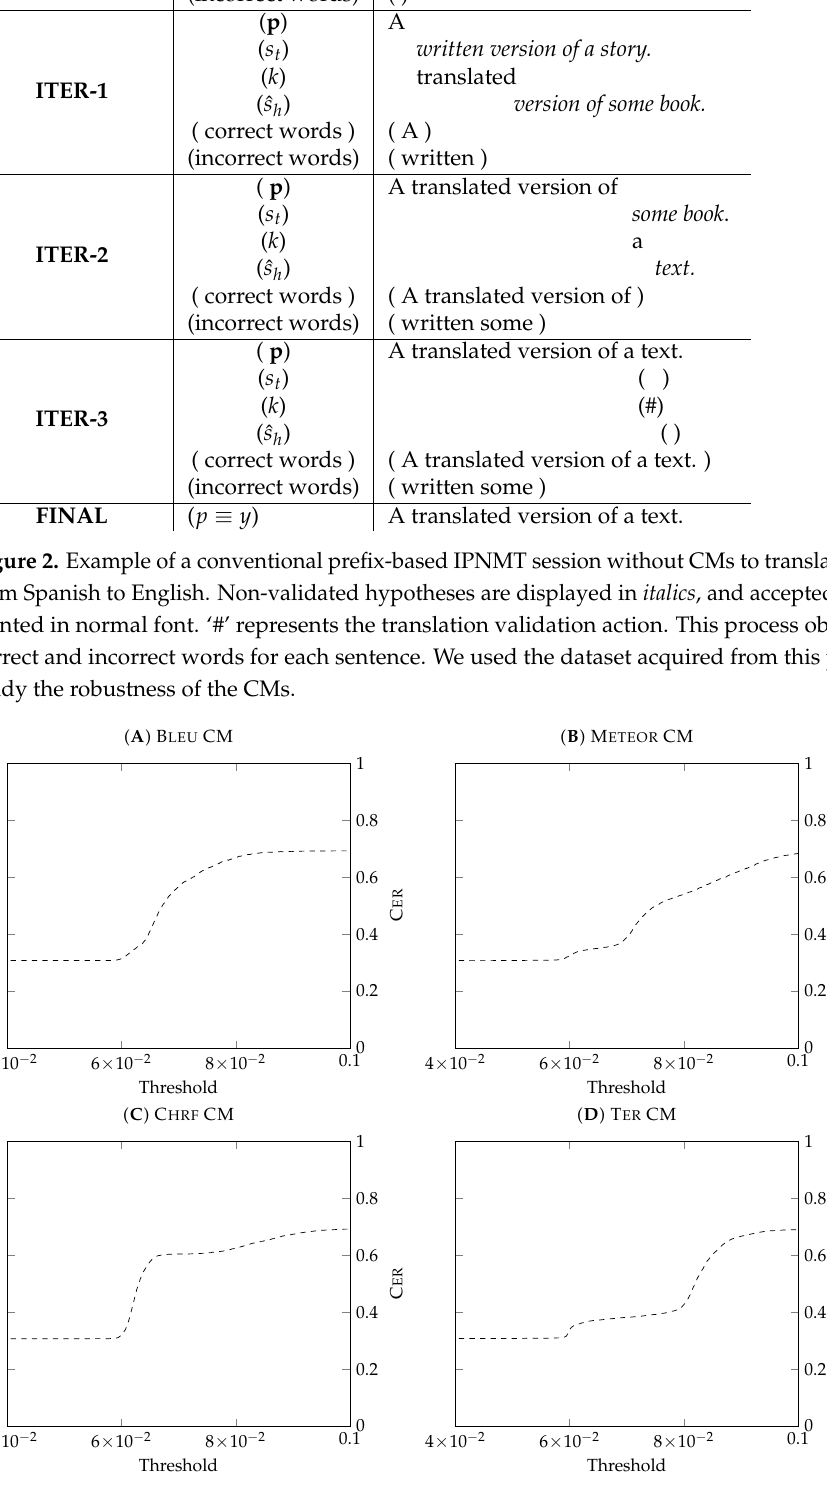
Figure 3. CER of the ( A ) Bleu CM, ( B ) Meteor CM, ( C ) Chrf CM, and ( D ) Ter CM. The X-axis represents the threshold values between 0.04 and 0.1, and the Y-axis the CER